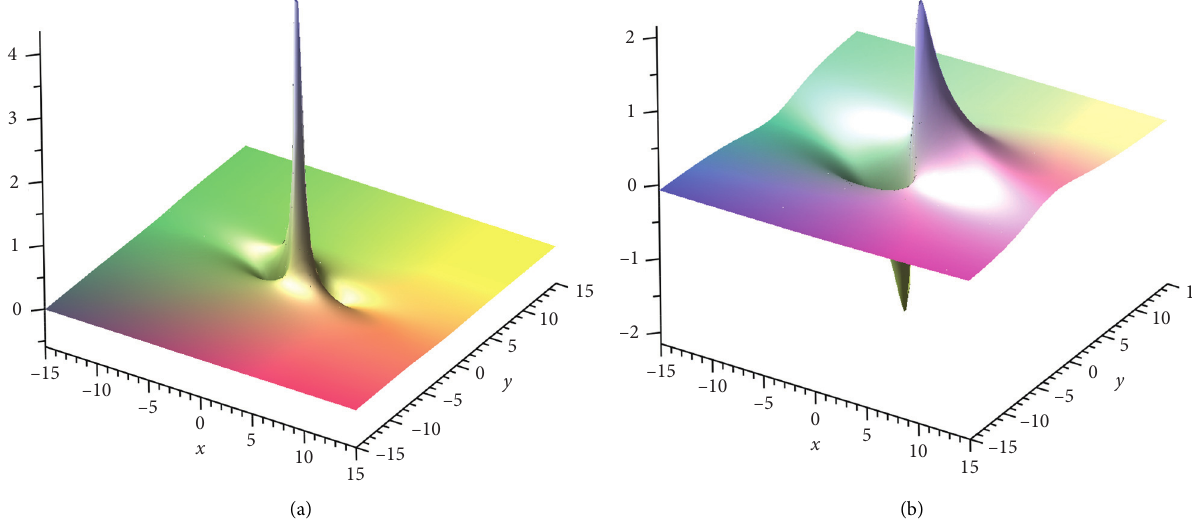
Figure 7: The lump solution u and v of equation (1) with the parameter selections a � 1 , b � 2 , δ Figure 7(a). The lump solutions v have one global maximum point and one global minimum point in Figure 7(b).